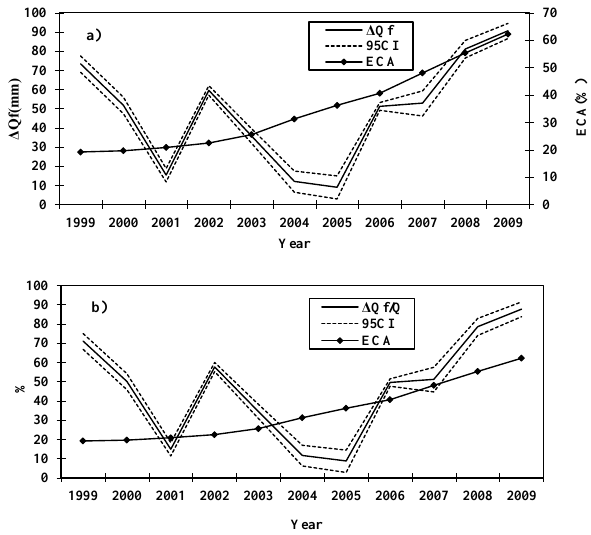
Figure 7 a) Annual mean flow deviation attributed to forest disturbance in mm(ΔQ f ); b) 1001 Fig. 7. (a) Annual mean flow deviation attributed to forest distur- Annual mean flow deviation attributed to forest disturbance in percentage( Δ Q f /Q) 1002 bance in mm; (b) annual mean flow deviation attributed to forest 1003 disturbance in